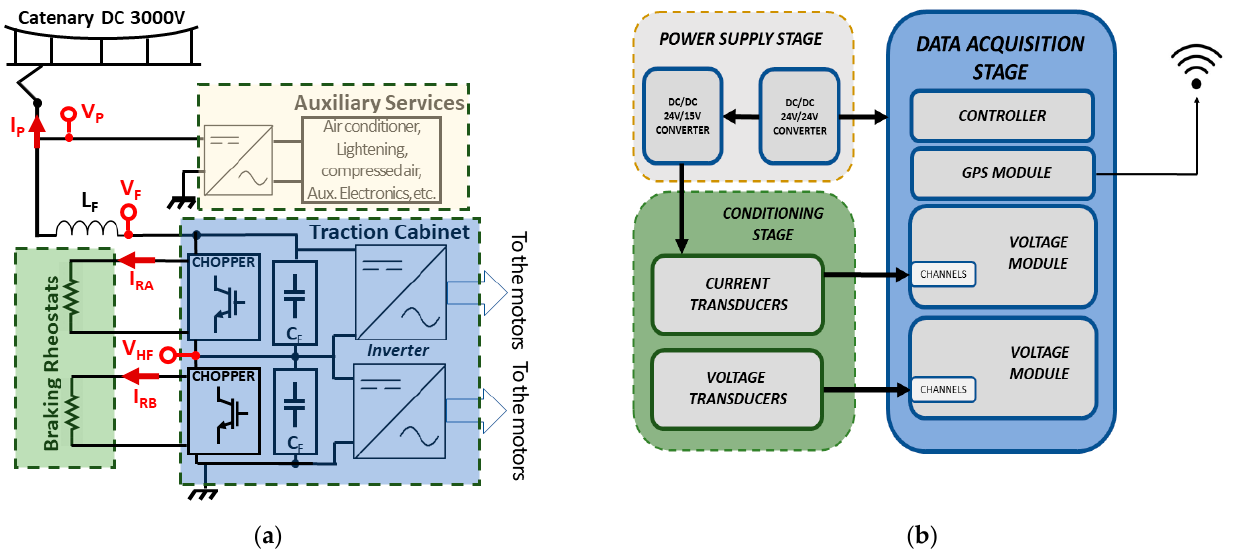
Figure 1. ( a ) Electrical scheme of E464 locomotive; ( b ) Simplified representation of the on-board train measurement system.